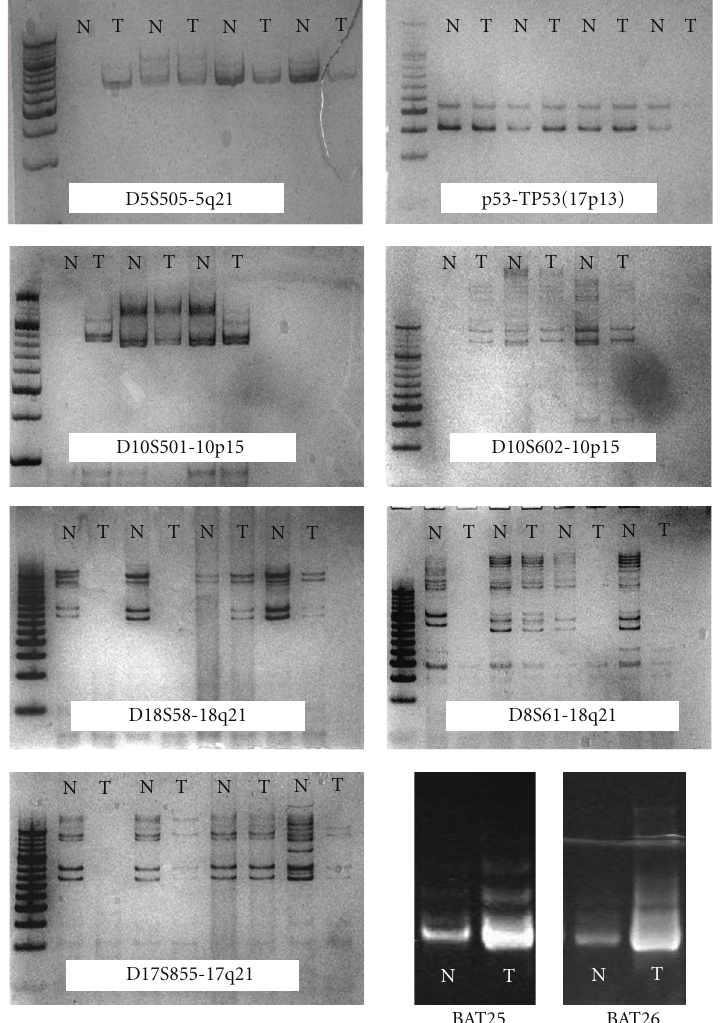
Figure 1: Representative example of loss of heterozygosity (LOH) and microsatellite instability (MSI). Seven loci that linked to tumor suppressor genes were used to identify significant structural chromosomal aberrations (D5S505, D10S501, D10S602, TP53, D17S855, D18S58 and D18S61). Microsatellite status was investigated for two di ff erent microsatellite marker loci (BAT25 and BAT26). (NL: normal; T: